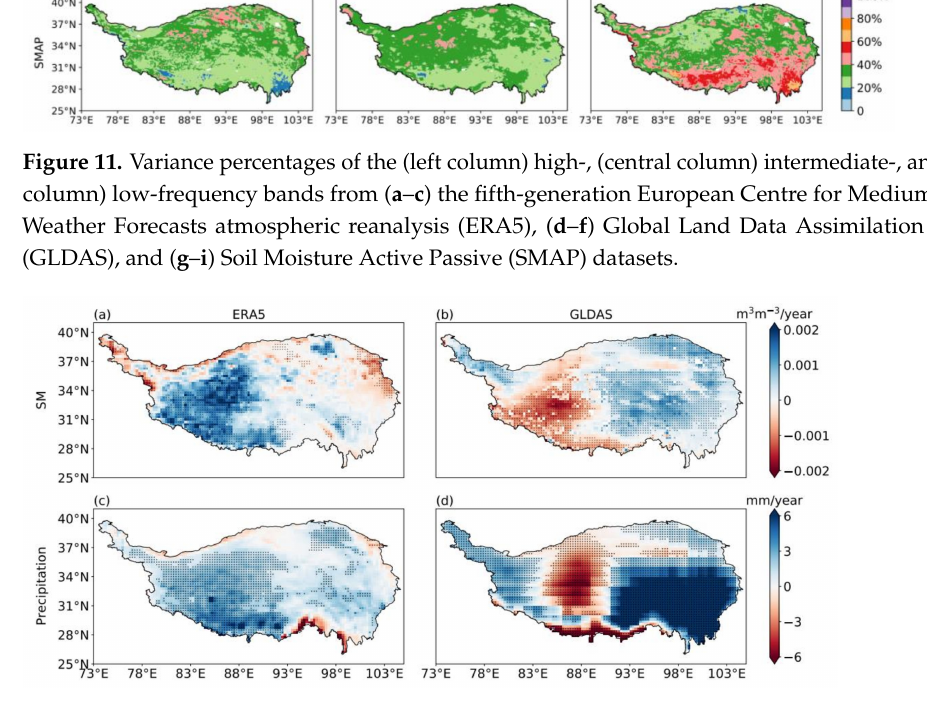
Figure 12. Annual trends of ( a ) soil moisture (SM) derived from the fifth-generation European Centre for Medium-Range Weather Forecasts atmospheric reanalysis (ERA5) dataset, ( b ) SM derived from the Global Land Data Assimilation System (GLDAS) dataset, ( c ) precipitation derived from ERA5, and ( d ) precipitation derived from GLDAS for the warm season between 1981 and 2021 over the Tibetan Plateau. Dots indicate areas with trends that are statistically significant at the 95% confidence level according to Student’s t